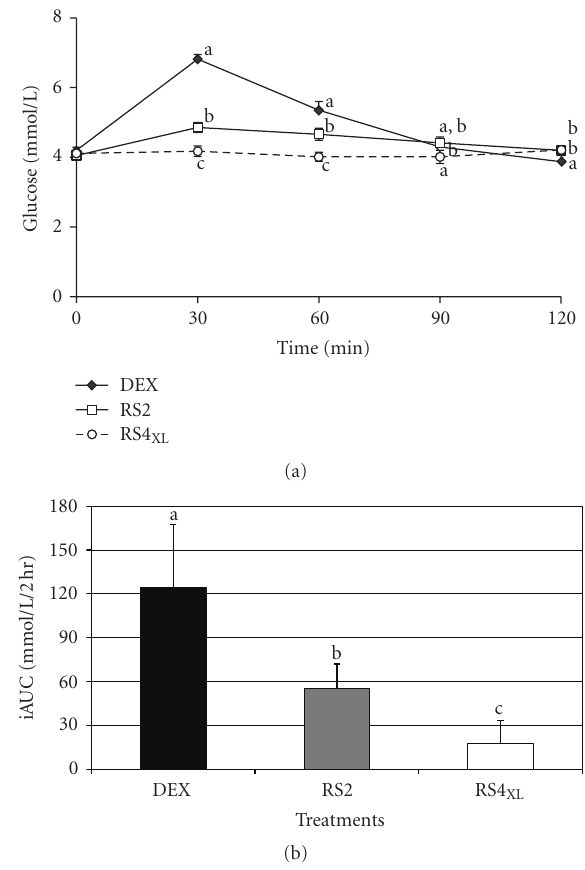
Figure 1: The glucose responses to 30g of carbohydrate from three treatments (DEX, RS2 and RS4 XL ). Panel (a) depicts the glucose changes over time, while panel (b) depicts the incremental area under the glucose curve. Data presented are mean ± SE; significance was set at P < . 05; and, di ff erent letters indicate di ff erence between